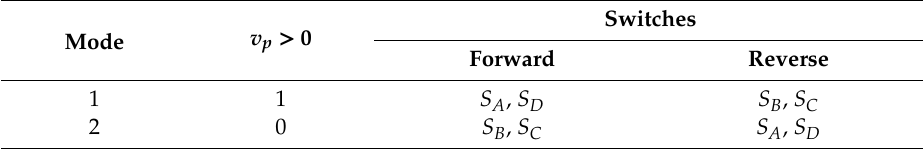
Table 2. Two operating states of the full-bridge converter.